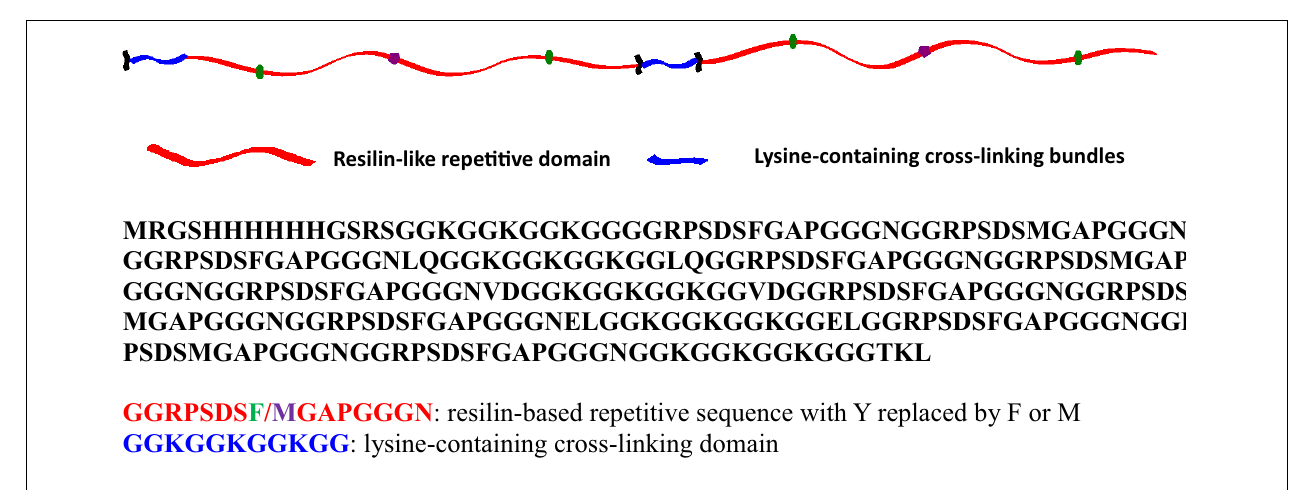
FIGURE 1 | Schematic of two repeats of the RLP, and the entire amino acid sequence of the RLP employed in these studies